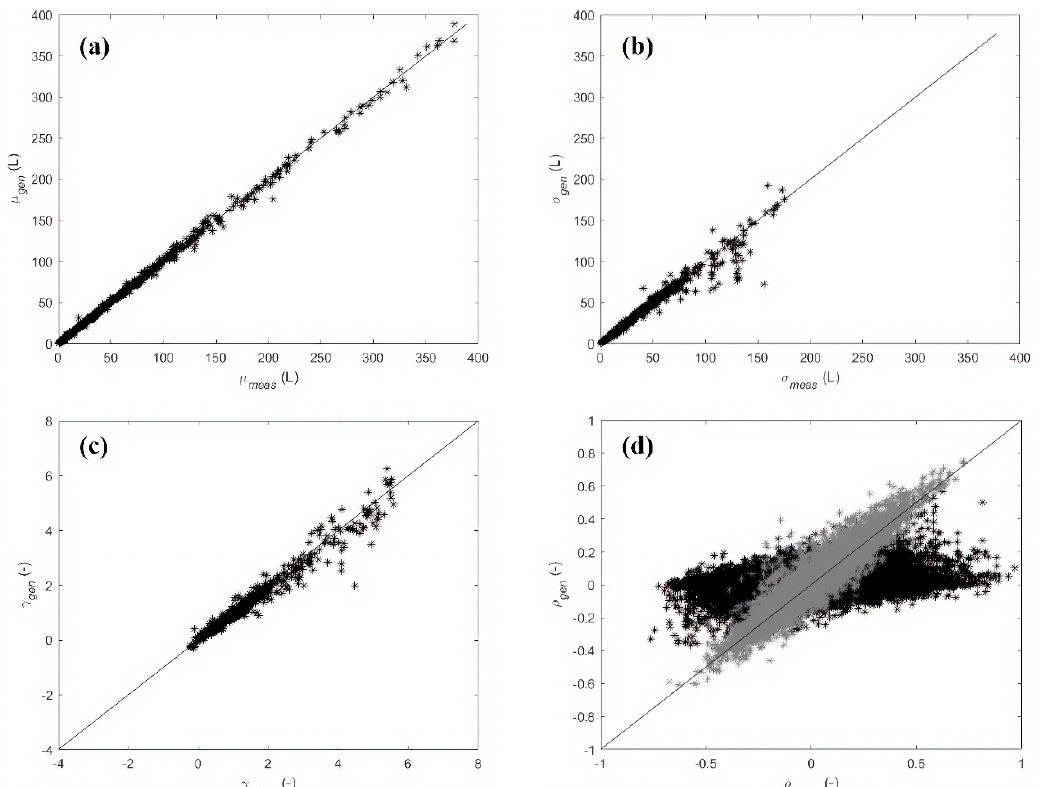
Figure 4. Case study 1 (Application 2)—Comparison between measured and generated hourly demands at single node level: ( a ) mean values µ , ( b ) standard deviation values σ , ( c ) skewness γ , ( d ) rank cross-correlations (black) ρ and ρ − lag 0 (gray).